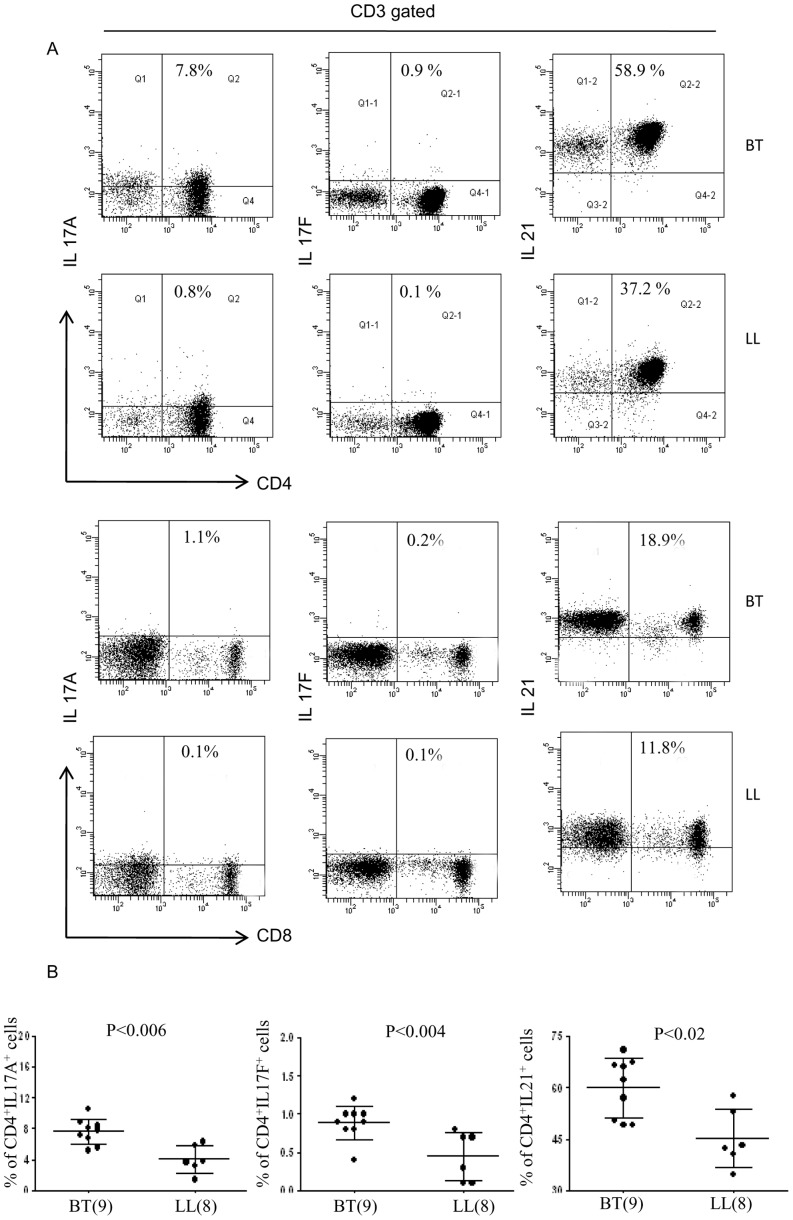
IL-17A, IL-17F and IL-21 producing cells are predominantly of CD4+ T cell lineage in leprosy.A. Representative data from one each of BT and LL patients of antigen stimulated PBMC using multi-color flowcytometry (see Material and Methods). The CD3 gated population showed intracellular cytokines predominantly in the CD4+ cells. Percentage of IL17A+ cells was higher than IL17F+ cells. % of IL21+ cells was highest than the others in both types of leprosy. CD8+ cells also showed IL-21 in a smaller percentage of cells as indicated in the figure. BT showed higher percentage of all there cytokines as compared to LL subjects. % of cells is given in the upper quadrant of the figure B. Scattergram depicting Mean % ± SD of the cytokine bearing cells in 9 BT and 6 LL subjects, confirming the significant increase in percentage of cells in BT for all 3 cytokines as indicated by p values given in the figure. Abbreviations as in Figure 1. Parenthesis shows number of subjects tested and numbers in figure give % of double positive cells.